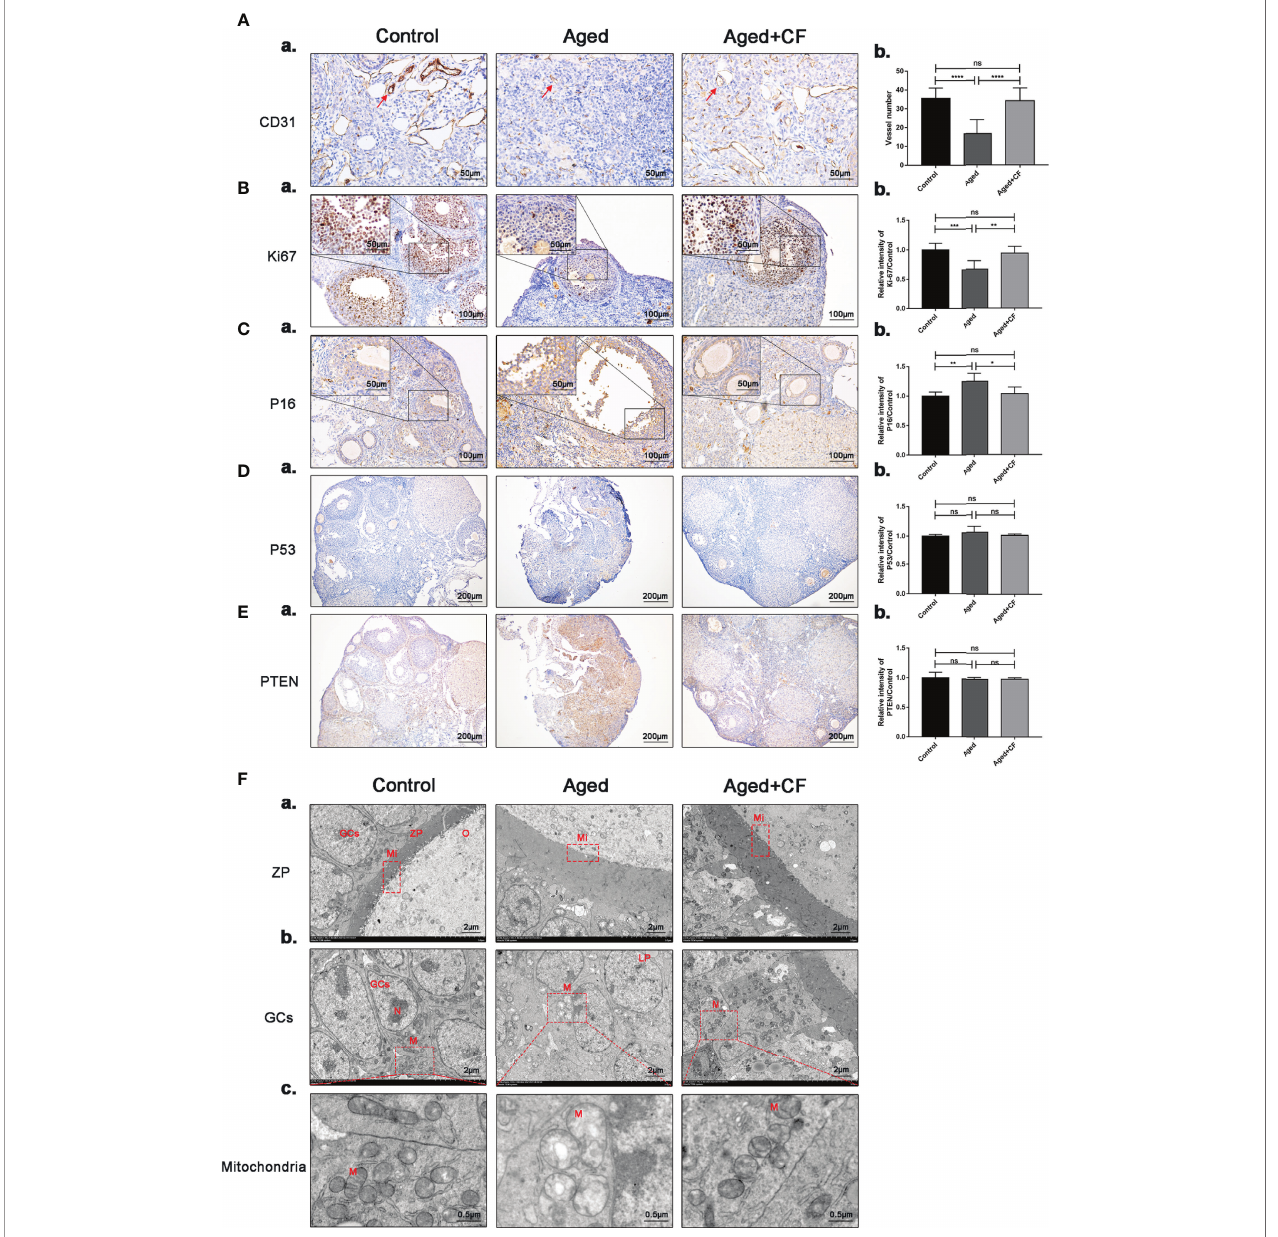
FIGURE 3 | CEFFE promotes angiogenesis in the medulla, promotes proliferation, and reduces senescence in ovarian granulosa cells. (A) IHC staining of the angiogenesis marker CD31 of ovarian sections (a) and statistical analysis (b) (n=4), the red arrows indicate blood vessels. Scale bar=50 m m. (B) IHC staining of the proliferation marker Ki67 of ovarian sections (a) and statistical analysis (b) (n=5-7), scale bar=100 m m. There are partial enlarged images of granulosa cells in the upper left corner of fi gure (a), scale bar=50 m m. (C) IHC staining of the senescence marker P16 of ovarian sections (a) and statistical analysis (b) (n=4), scale bar=100 m m. There are partial enlarged images of granulosa cells in the upper left corner of fi gure (a), scale bar=50 m m. (D) IHC staining of the suppressive gene PTEN of ovarian sections (a) and statistical analysis (b) (n=4), scale bar=200 m m. (E) IHC staining of the oncogenic gene P53 of ovarian sections (a) and statistical analysis (b) (n=4), scale bar=200 m m. (F) Effects of CEFFE treatment on the ultrastructural changes of zona pellucida (a), granulosa cells (b), and mitochondria (c) were observed via TEM. Scale bar=2 m m or 0.5 m m. O, Oocyte; GCs, granulosa cells; ZP, Zona pellucida; Mi, microvilli; LD, Liquid droplet; N, Nucleus; M, mitochondria. Data are represented as the mean ± SD, ns: P > 0.05, * P < 0.05, ** P < 0.01, *** P < 0.001, and **** P <